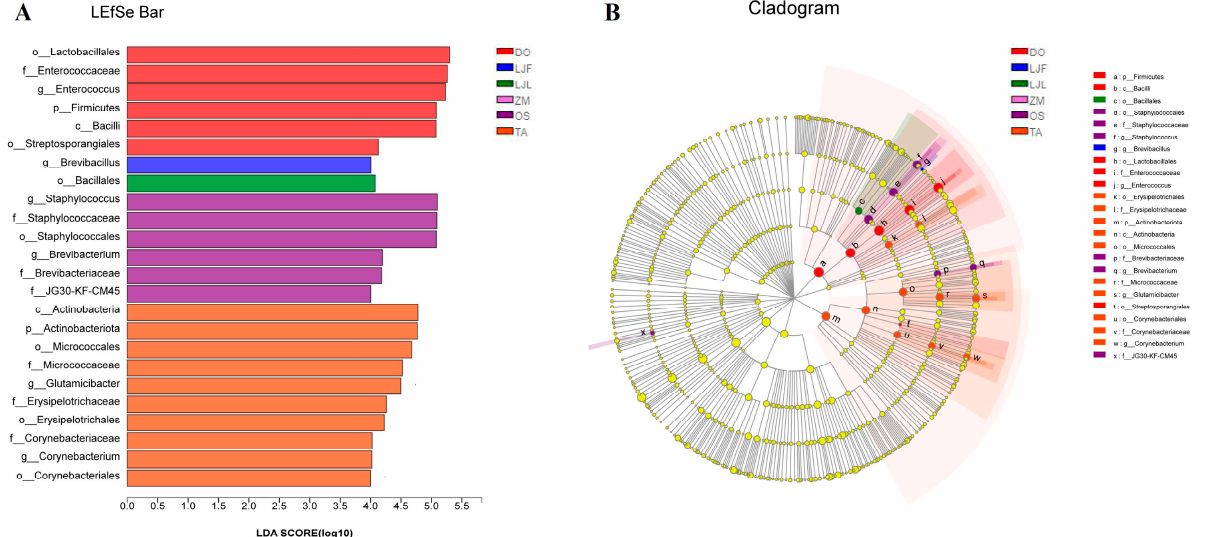
Figure 5. Taxonomic biomarkers of bacterial community in Spodoptera frugiperda feeding on different hosts. Scores ( A ) and cladogram ( B ) of taxonomic biomarkers were identified by linear discriminant analysis (LDA) using LEfSe. Lowercase letters represents different bacterial taxa. Different colors represent different treatments, and the different colored nodes represent the bacteria taxa enriched in that treatment. Nodes with yellow indicate no significant difference. Abbreviations in the figure represent different treatments: ZM, maize; TA, wheat; OS, rice; LJF, honeysuckle flowers; LJL, honeysuckle leaves; and DO, Chinese yam.